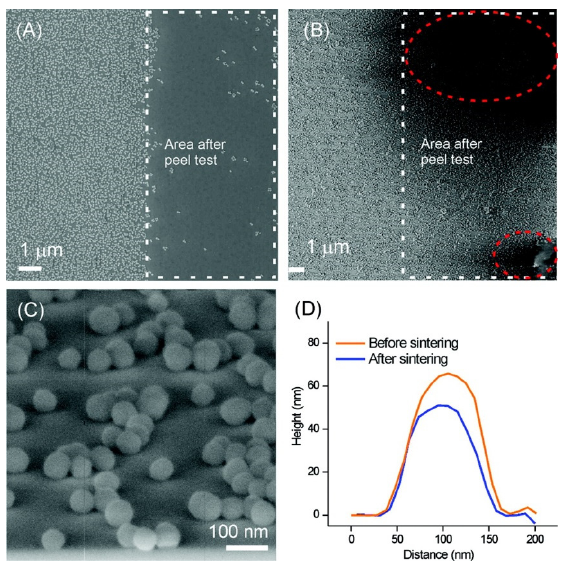
Figure 6. SEM images of the peel test on dip ‐ coated nanoparticle films before ( A ) and after a sintering process ( B ); white boxes indicate the areas after peel tests, while red ‐ dot ellipsoids show the area where scotch tape adhesives remained on the substrate after the test; ( C ) Titled SEM image of the nanoparticles after sintering, and ( D ) averaged height profiles of the nanoparticles before and after sintering (as measured by AFM) [32].